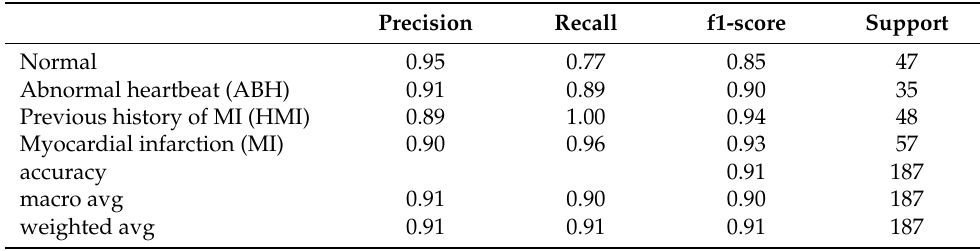
Table 8. Classification report for VGG16 transfer learning.